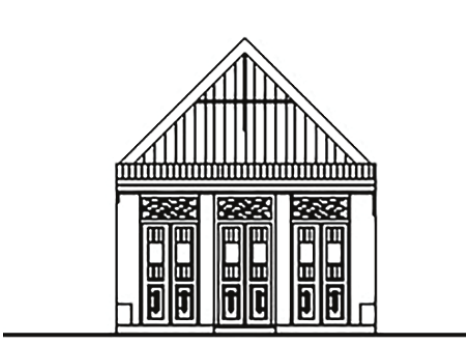
Figure 12. Ground plan of omah a vernakular javanese house in Kauman (source: Suprapti et al., 2017)